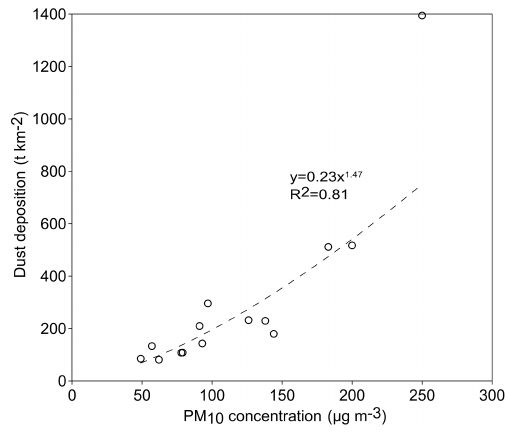
Figure 7. Relationship between annual dust deposition and PM 10 concentration in Xinjiang Province. Each point represents data av- eraged across 2000 to 2013 at one